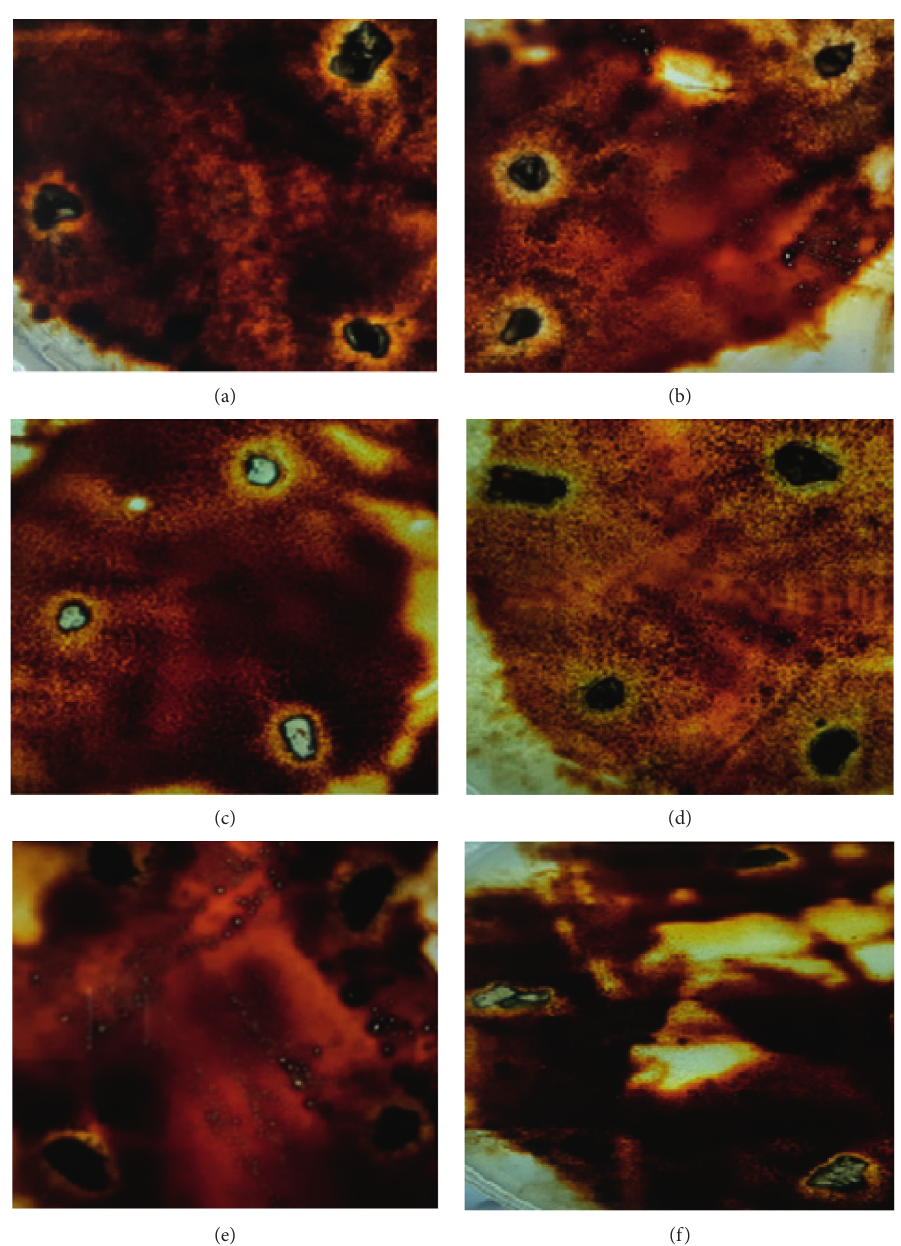
Figure 3: Fungal isolates that were grown on solidified Czapek’s Dox medium complemented with petroleum hydrocarbons as a solitary carbon source have shown a clear modification in the appearance of petroleum oil surrounding them. (a) Penicillium chrysogenum ; (b) Scopulariopsis brevicaulis ; (c) Stemphylium botryosum ; (d) Alternaria alternate ; (e) Cladosporium sphaerospermum; and (f) Curvularia